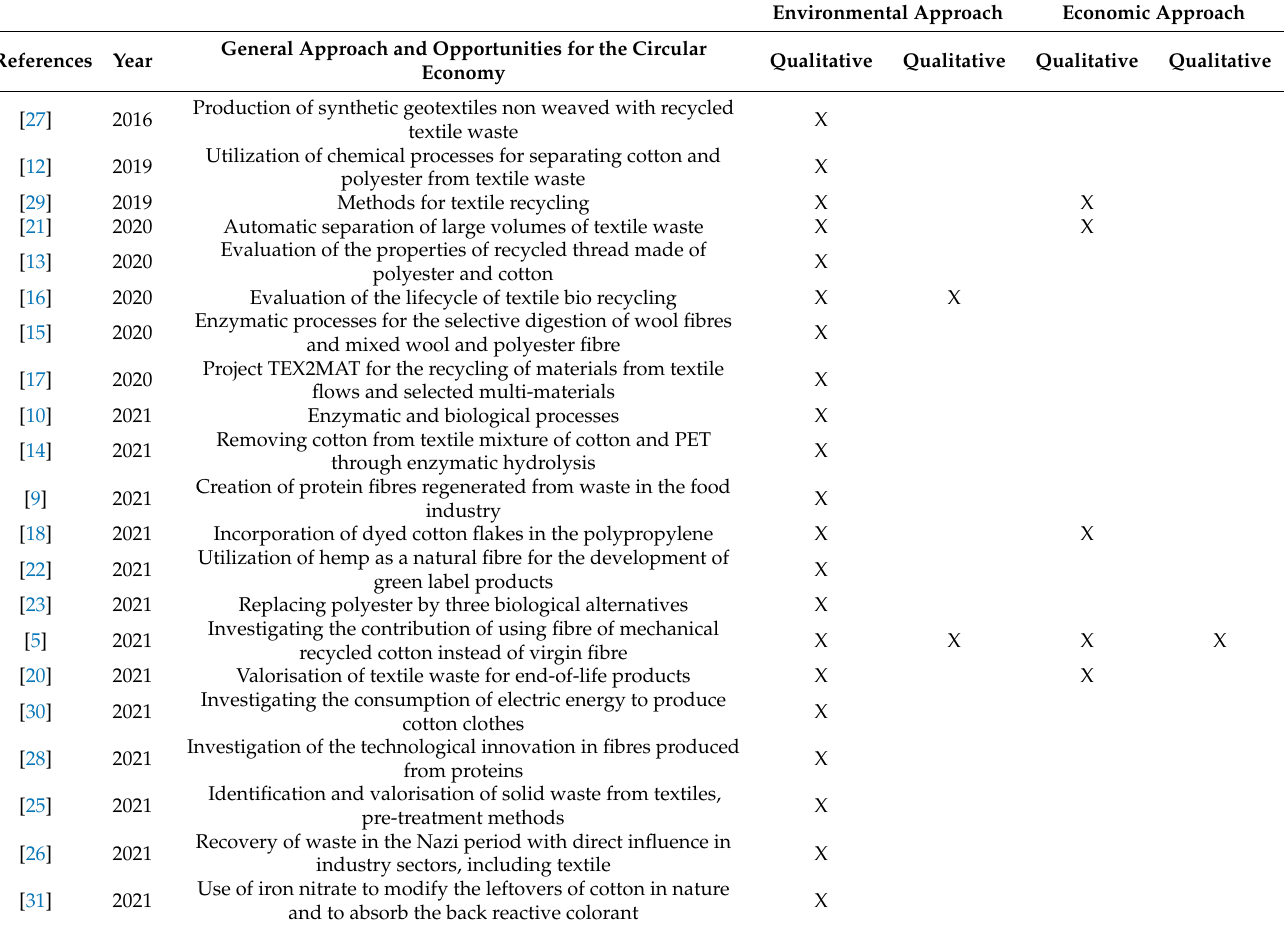
Table 1. Overview of existing literature focusing on the textile industry and the approaches for economic and environmental gains, and opportunities for the circular